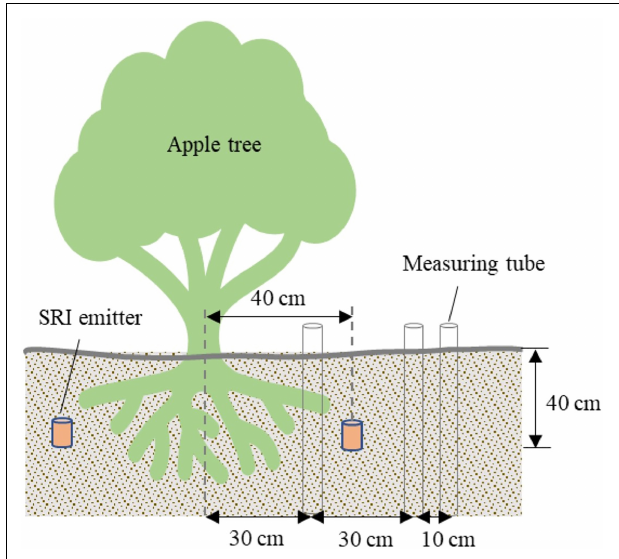
FIGURE 3 | Arrangement of measuring tubes and surge-root irrigation